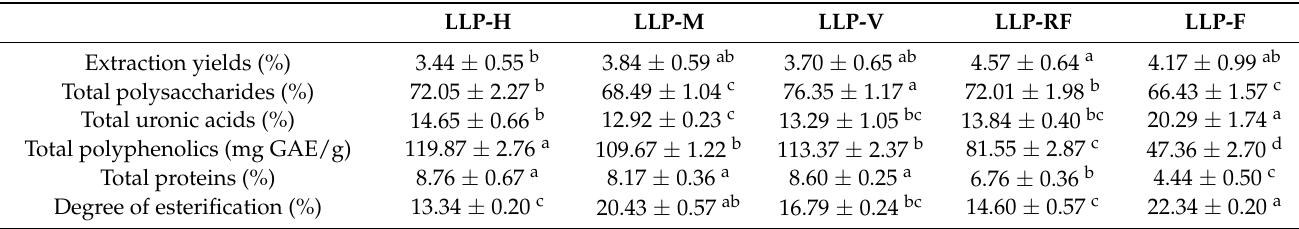
Table 1. Extraction yields and chemical compositions of LLPs.